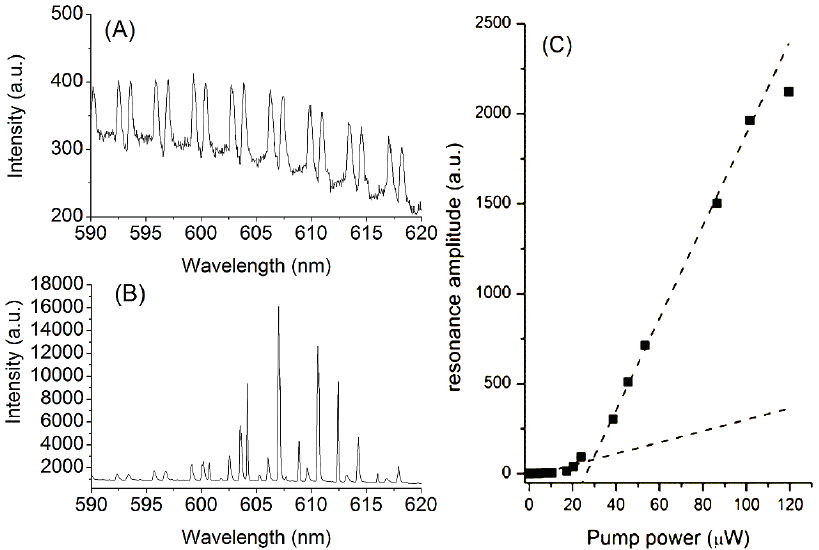
Figure 2. ( A , B ) WGM spectra below and above the lasing threshold respectively; ( C ) resonance amplitude as function of the pump